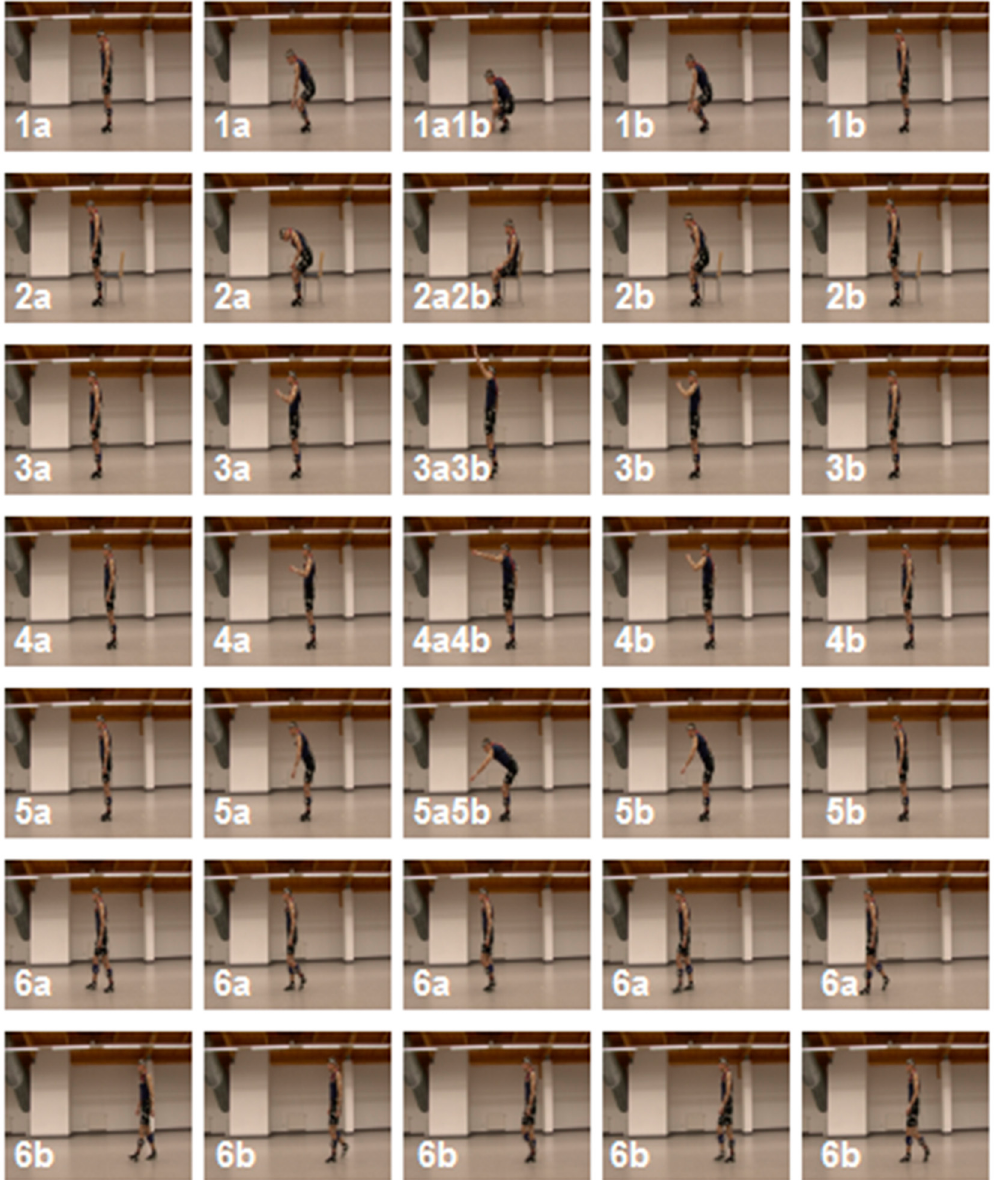
Figure 3. Selected (first, middle, and end, respectively) video frames presented the investigated movements (activities 1a ÷ 6b). Transitions between the specific successive activities are named 1a1b ÷ 5a5b.